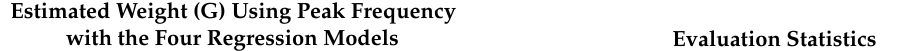
Table 2. Estimation the turkey weight using the peak frequency of vocalizations in each trial based on the regression